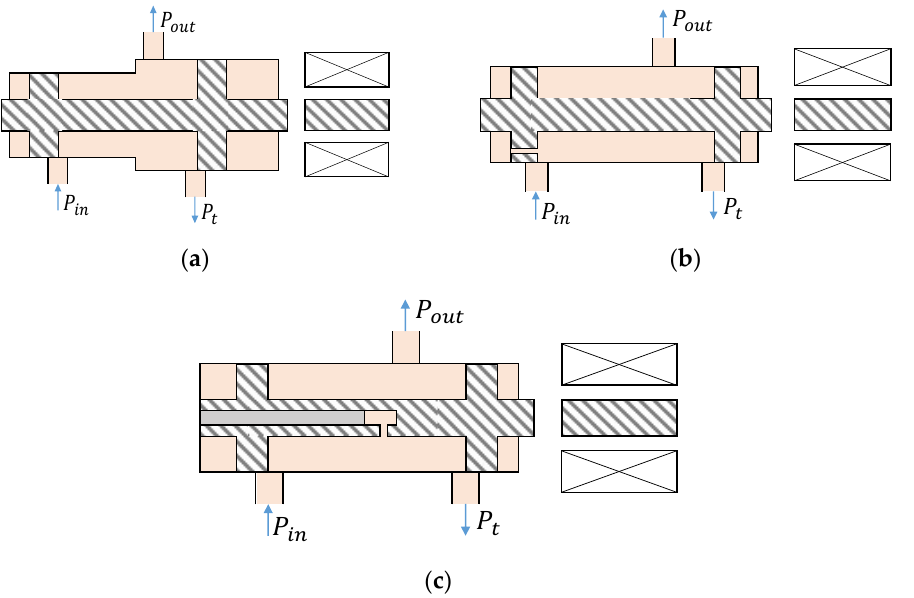
Figure 1. Types of pressure-reducing spools. ( a ) Differential-area type spool. ( b ) Differential-pressure type spool. ( c ) Spool used in this study.